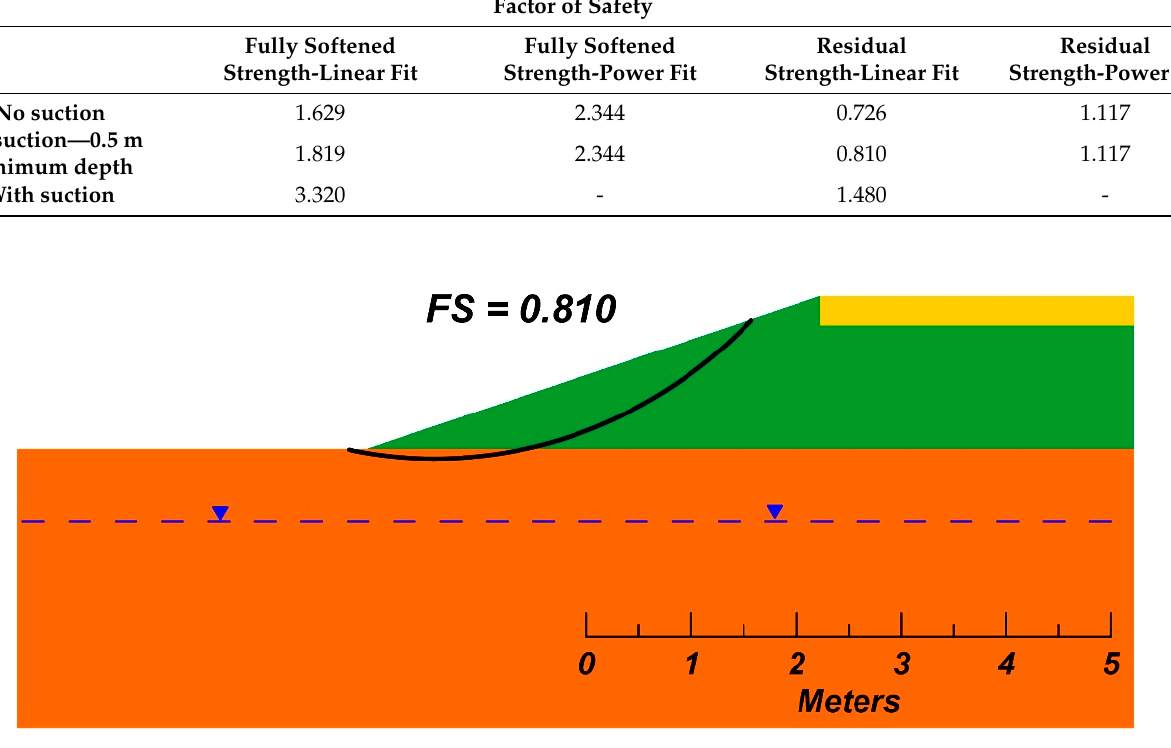
tion and a 0.5 m minimum depth constraint. depth